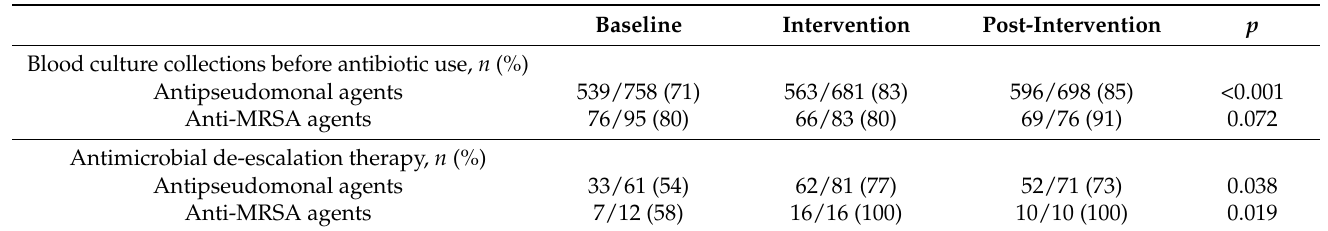
Table 2. Rate of blood culture collections before initial antibiotic use and de-escalation therapy. Baseline Intervention Post-Intervention p Blood culture collections before antibiotic use, n